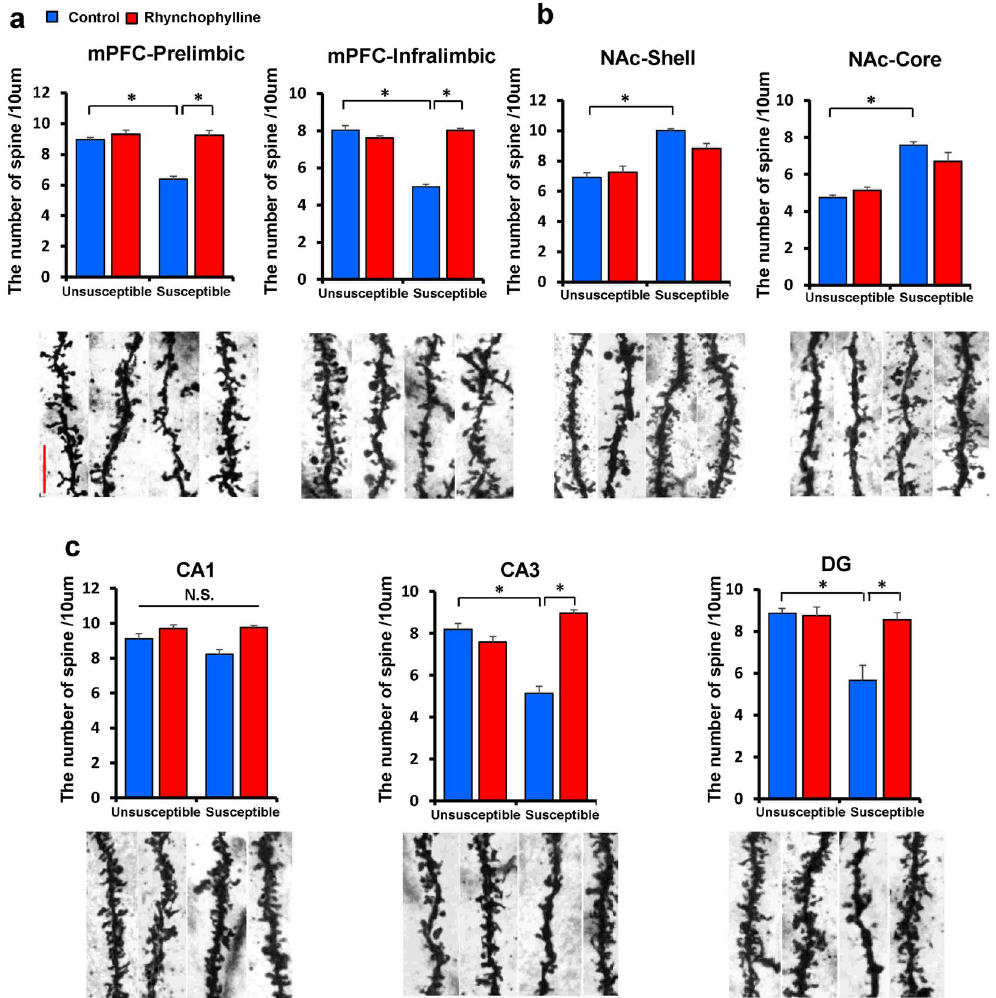
Figure 5. Effects of rhynchophylline on stress-induced changes in the spine density within brain. ( a , b and c ) Representative photomicrographs of Golgi-Cox stained pyramidal neurons in the prelimbic and infralimbic of mPFC, NAc-shell and NAc-core, CA1, CA3 and DG of the hippocampus, from each group. Scale bar = 10 μ m. The values represent the mean ± S.E.M. (n = 6). * P < 0.05 compared with the control + stressed group. N.S.: not